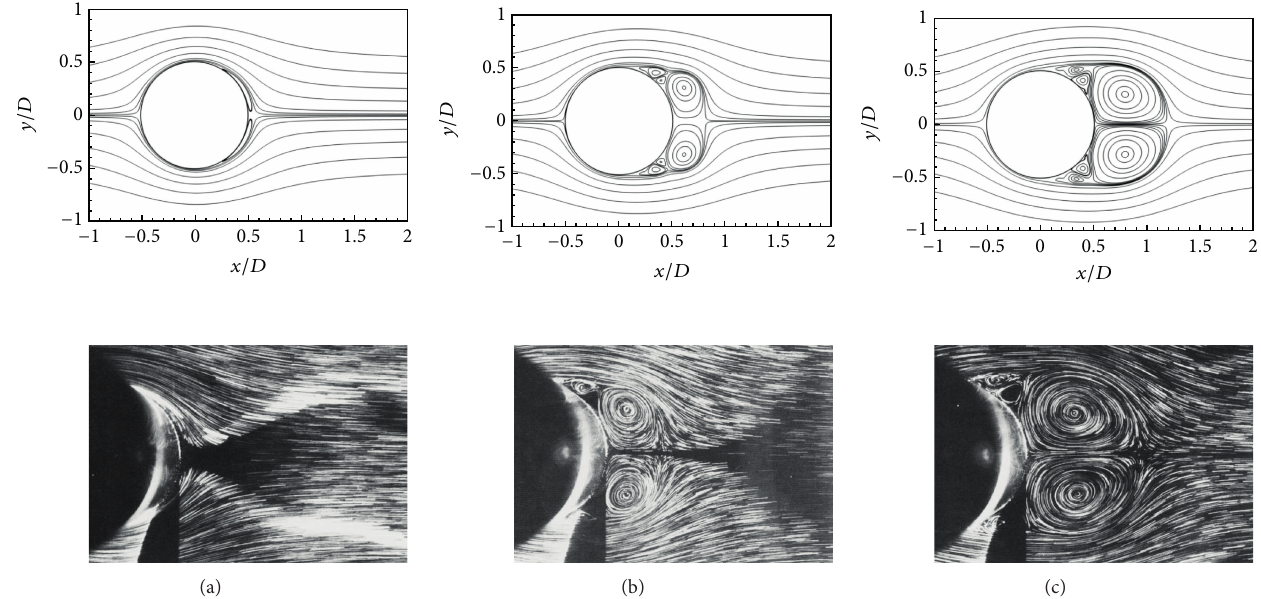
Figure 7: Instantaneous streamlines for an impulsively started circular cylinder at Re = 3000 : (a) 𝑇 = 1 , (b) 𝑇 = 3 , and (c) 𝑇 = 5 , compared with flow visualization results of Loc and Bouard (1985) [21].